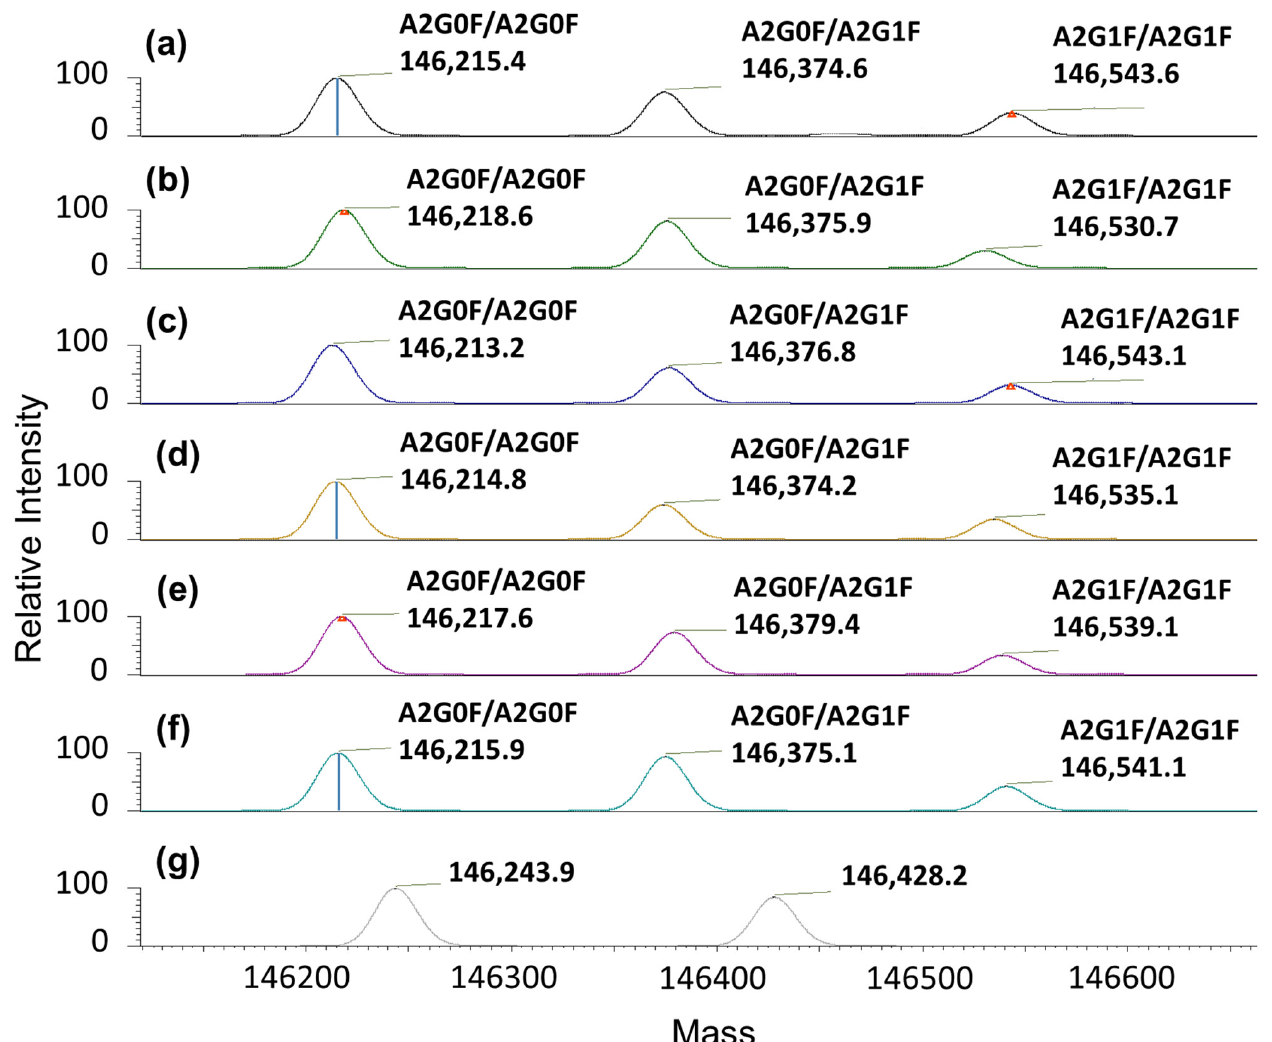
Figure 4. Deconvoluted mass spectra for nivolumab samples (10 mg/mL) showing the mass isoform profile with their proposed N-glycoforms: ( a ) fresh/control sample; ( b ) 40 °C/1 h exposure stress; ( c ) 60 °C/1 h exposure stress; ( d ) FTC 1; ( e ) FTC 5; ( f ) agitation stress; and ( g ) light stress.